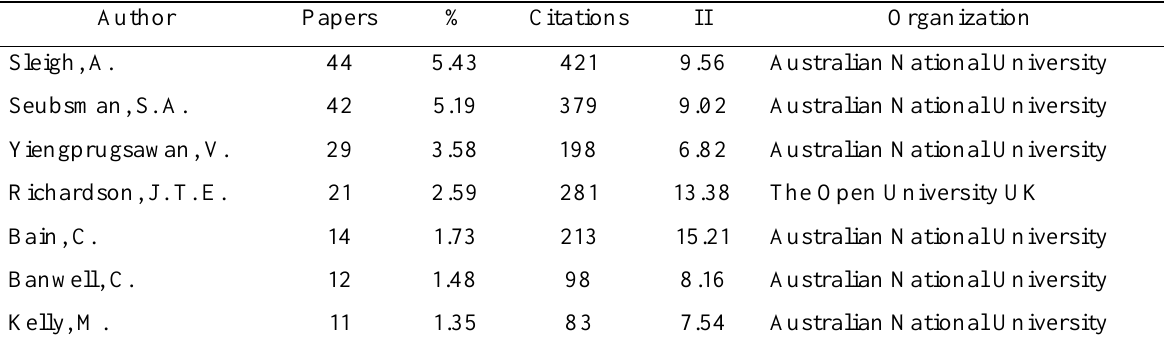
Authors With the Most Output on